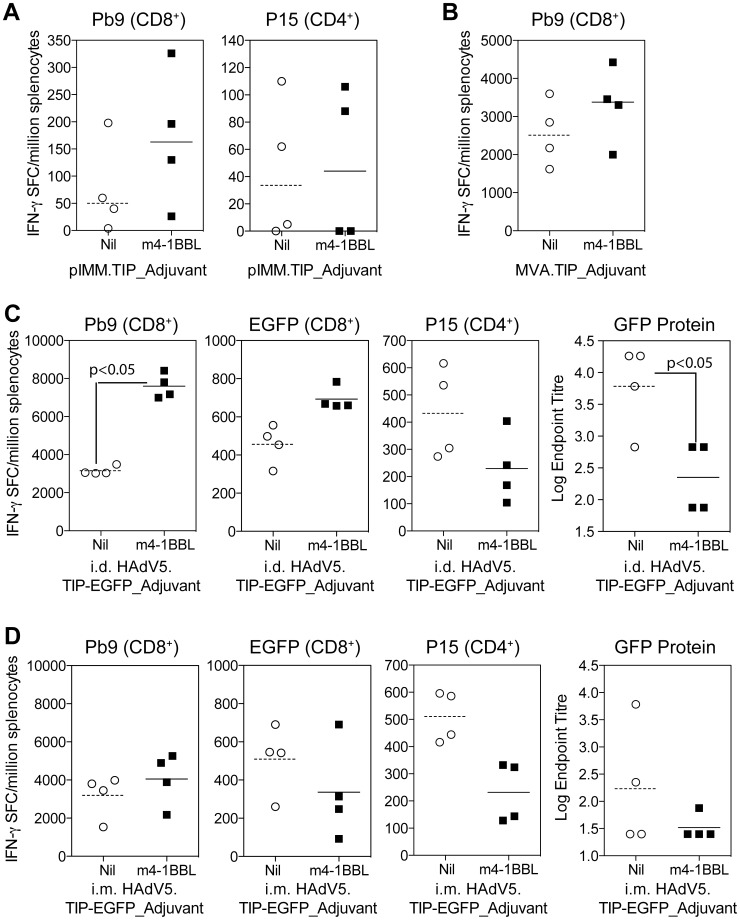
Screening of vectors in Balb/c mice.
A) Balb/c mice were immunised i.m. with 50 µg of DNA plasmid pIMM.TIP or pIMM.TIP_m4-1BBL, spleens harvested at day 7 and the response to Pb9 and P15 measured by ELISpot. B) Balb/c mice were immunised i.d. with 106 PFU of MVA.TIP or MVA.TIP_m4-1BBL, spleens were harvested 1 week later and the response to Pb9 measured by ELISpot. Responses to P15 were not above background levels. C & D) Balb/c mice were immunised either i.d. (C) or i.m. (D) with 108 iu of HAdV5.TIP-EGFP or HAdV5.TIP-EGFP. Spleens and serum were harvested 2 weeks later and the response to Pb9, EGFP and P15 measured by ELISpot and antibodies to GFP protein measured by ELISA. Data was analyzed with a 2-way analysis of variance with a post-hoc Bonferroni test; p values denote the level of statistical significance. For all graphs, the bar represents the median per group with each individual animal displayed as a single point.